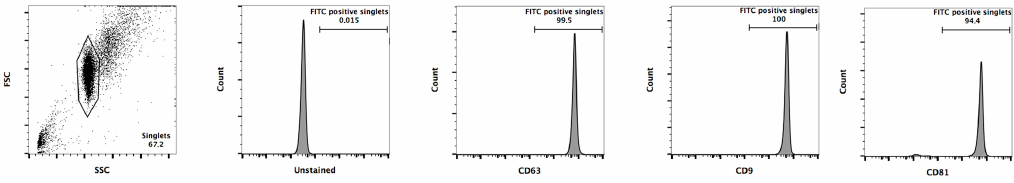
Figure 2. Identification of canine exosomes. Exosomes, obtained from canine serum, were labeled with Exo-FITC and incubated respectively with anti-CD63, anti-CD9 and anti-CD81 Exo-Flow FACS magnetic beads. The data percentage of captured exosomes is shown.